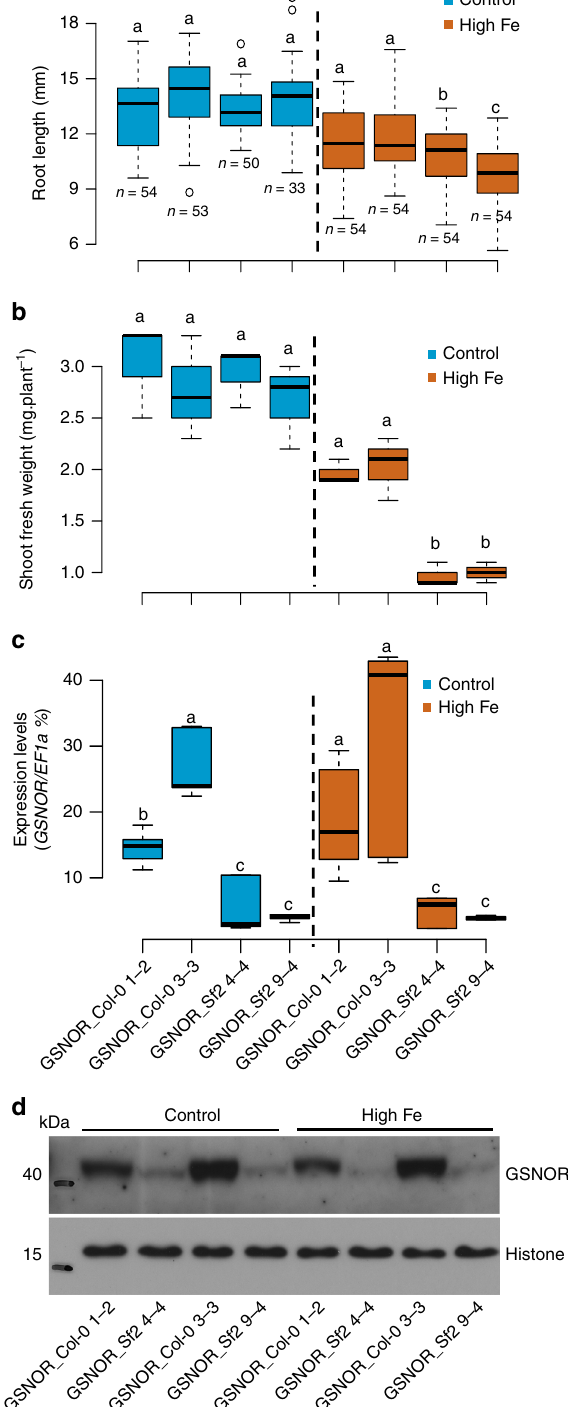
OsGSNOR knockout lines ( Osgsnor-1 , Osgsnor-2 , and Osgsnor-3 ) containing frameshifts, displayed slightly reduced root growth under control conditions, but were dramatically more sensitive to high Fe (in hydroponics with 1000 µM Fe) compared to the wild- type ZH11 (Fig. 7b, c; Supplementary Fig. 11a, b). At this early stage, shoot growth was also slightly retarded in these three OsGSNOR knockout lines in control conditions, and much more so in high Fe conditions (Supplementary Fig. 11c). The reduction of height in Osgsnor knockout lines compared to wild-type NATURE COMMUNICATIONS| (2019) 10:3896